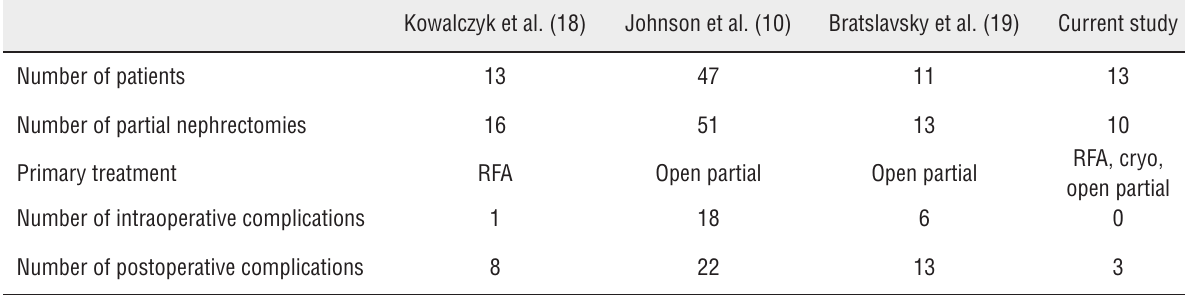
Table 2 - Intra and postoperative complication rates in previously published